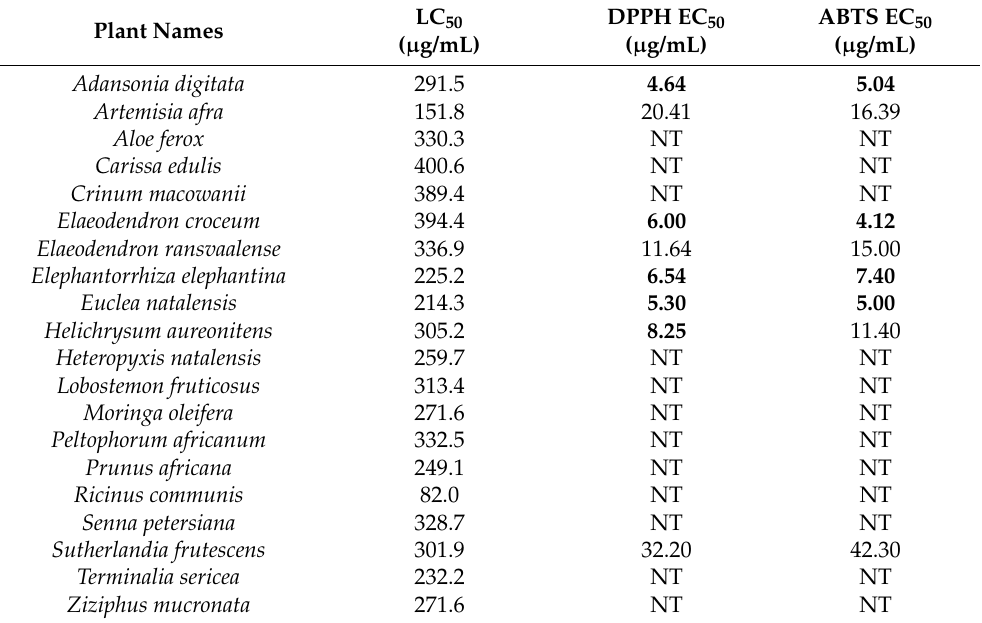
Table 2. Cytotoxicity effects of extracts from 20 plants with antiviral activity. Lethal